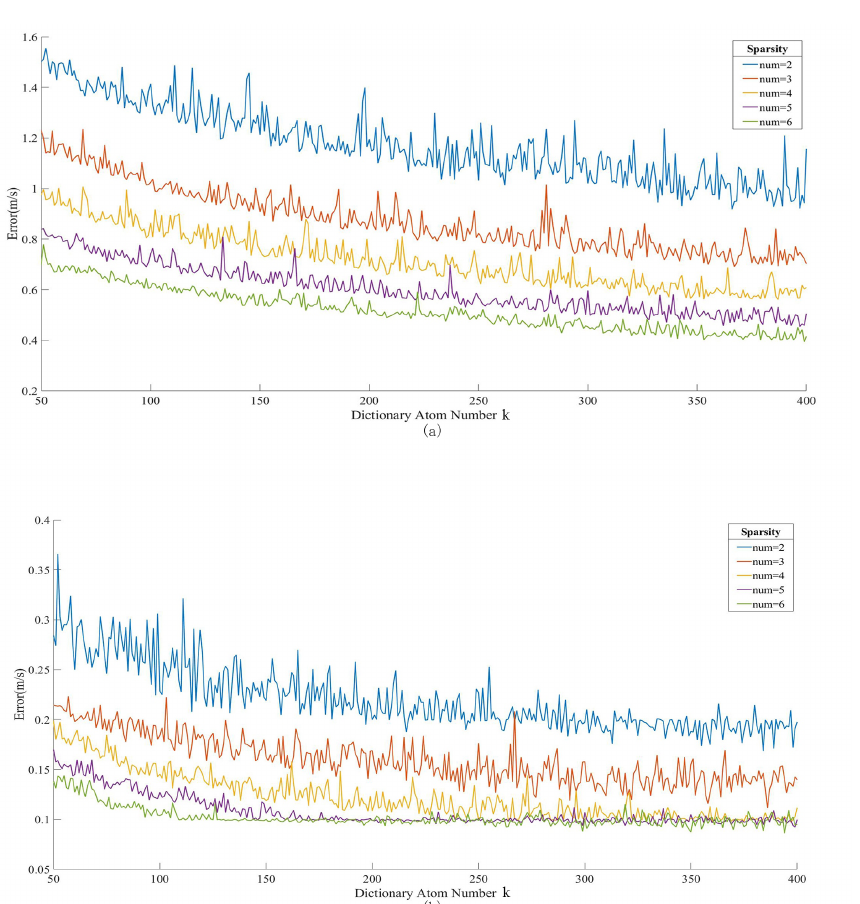
Figure 6. The effect of dictionary atom number k and sparsity T on Error MAD (( a ) is 10.95° N, 112.95° E; ( b ) is 0.95° N, 4.95°